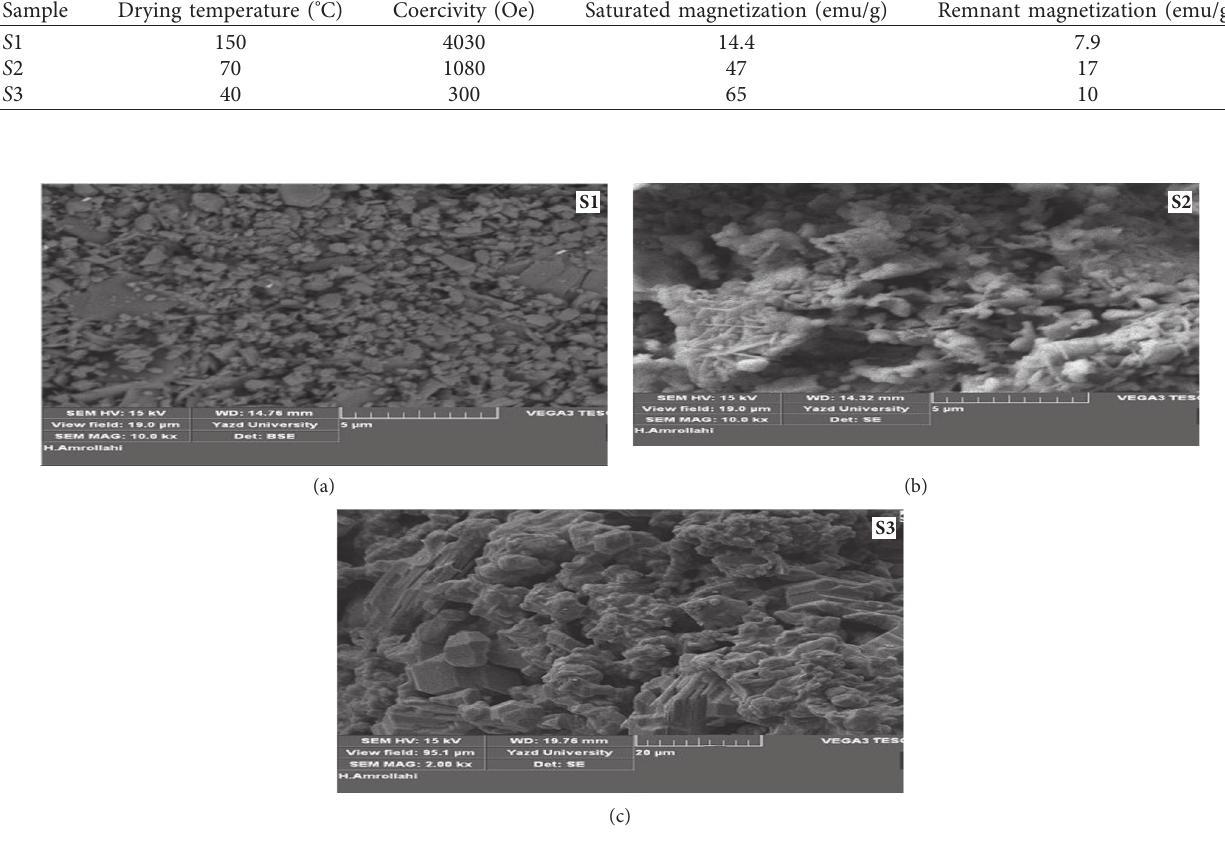
Figure 5: SEM samples